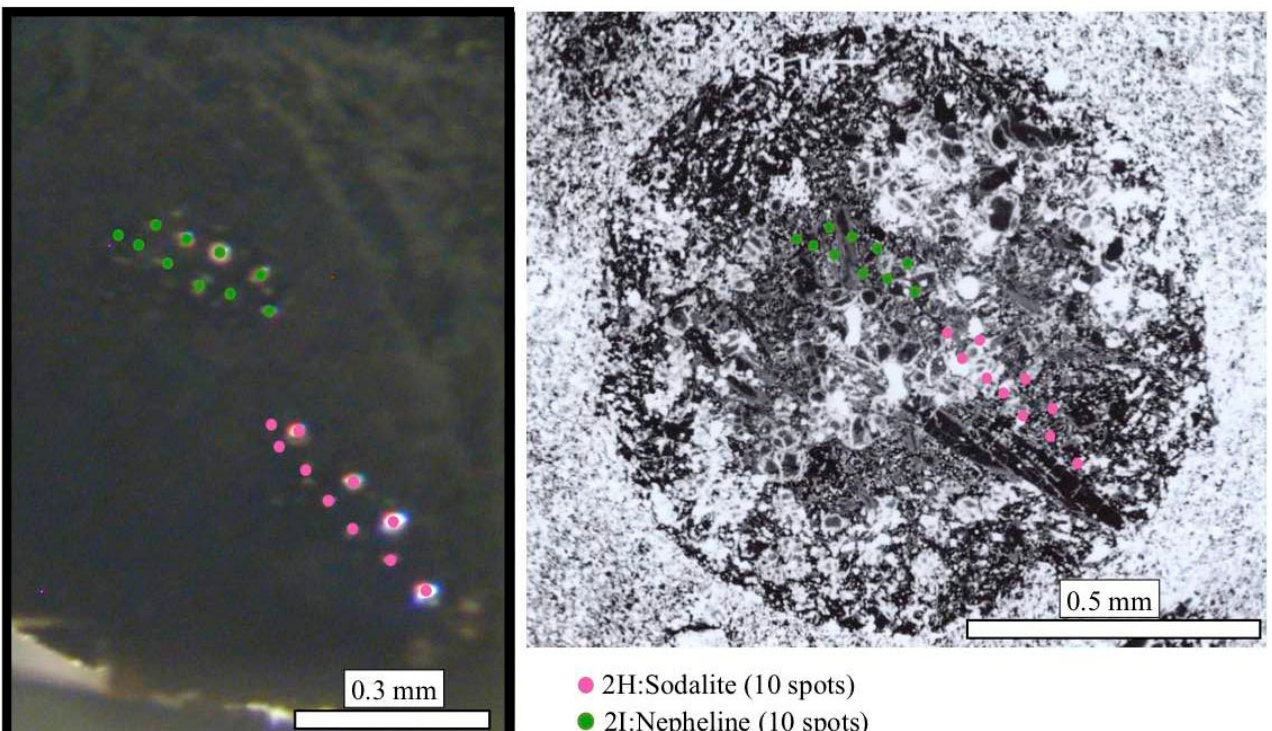
Figure 6. Optical view and BSE image of POC-13 showing laser shot locations. The number of laser spots is ten shots for the 2H sodalite phase (pink) and for the 2I nepheline phase (green).